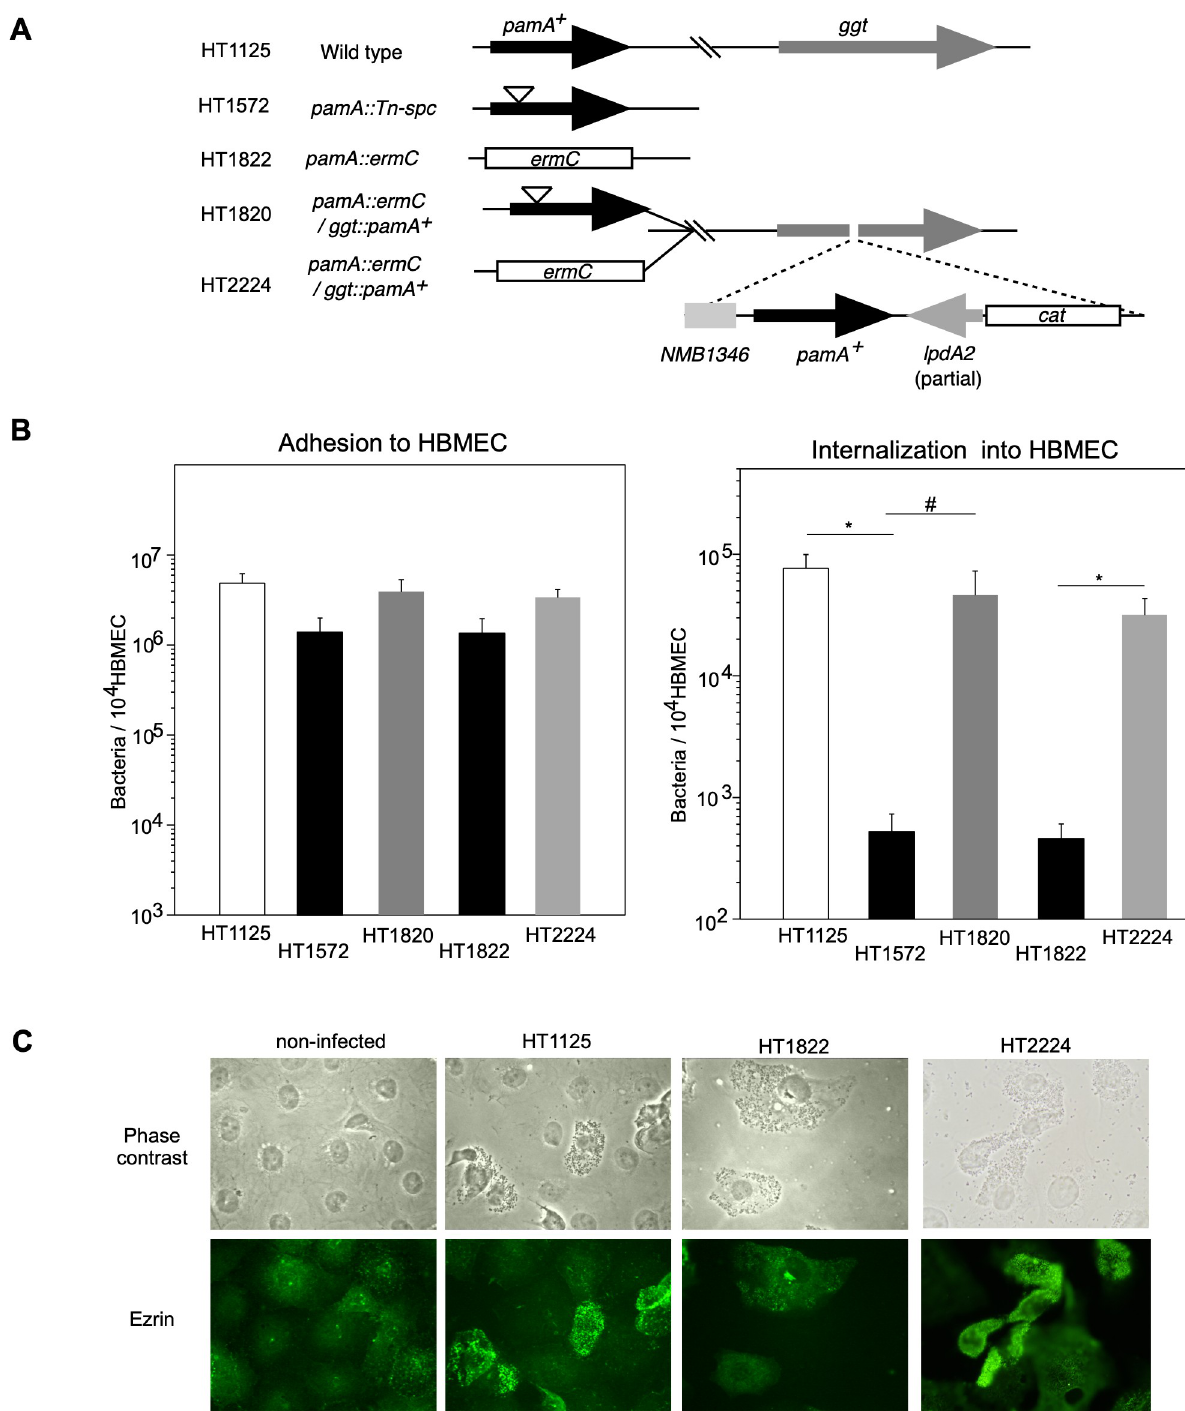
Fig 1. Characterization of Δ pamA N . meningitidis mutant. (A) Schematic representation of the wild-type, insertion, and deletion mutants in the pamA gene and ectopic complementation of the pamA + gene at the ggt locus in N . meningitidis strains. (B) Effect of Δ pamA mutation on N . meningitidis infection of HBMEC. The adherence (left) and internalization (right) of pamA N . meningitidis mutants to HBMEC, and the effects of complementation of the pamA + gene in the pamA deletion mutant on bacterial infection. Each value is the mean ± standard error of the mean (CFU per 10 4 HBMEC) from at least four experiments. Open, filled, light gray, and dark gray bars indicate the bacterial number of N . meningitidis wild- type pamA + (HT1125), pamA :: Tn-spc (HT1572), and Δ pamA :: spc (HT1822), and pamA - mutants in which the pamA + gene was ectopically complemented (HT1736 and HT2224), respectively (see S1 Table). � P < 0.01, # P < 0.05, significantly different from the pamA + strain or pamA -